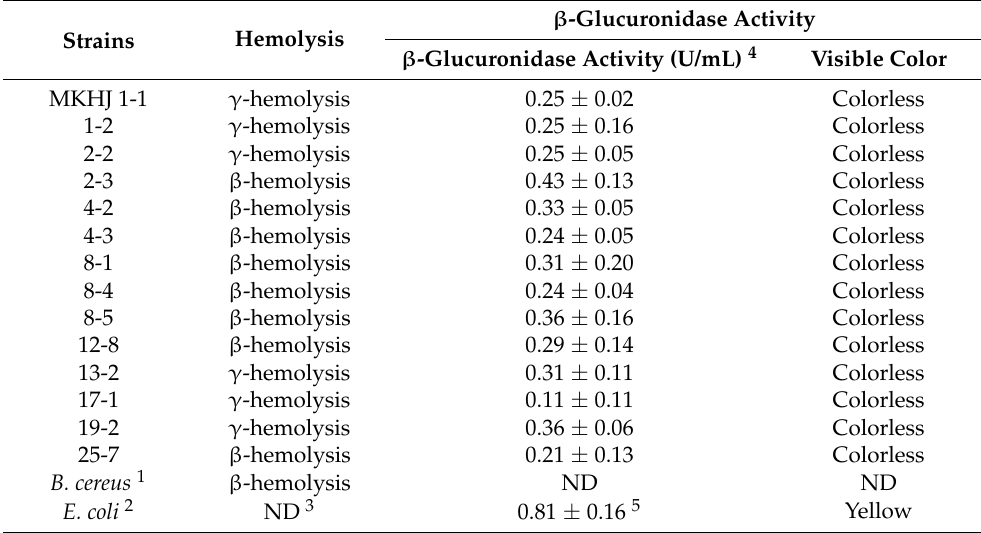
Table 2. Hemolysis and β -glucuronidase activity of selected strains. β -Glucuronidase Activity Strains Hemolysis β -Glucuronidase Activity (U/mL) 4 Visible Color MKHJ 1-1 γ -hemolysis 0.25 ± 0.02 Colorless 1-2 γ -hemolysis 0.25 ± 0.16 Colorless 2-2 γ -hemolysis 0.25 ± 0.05 0.43 ± 0.13